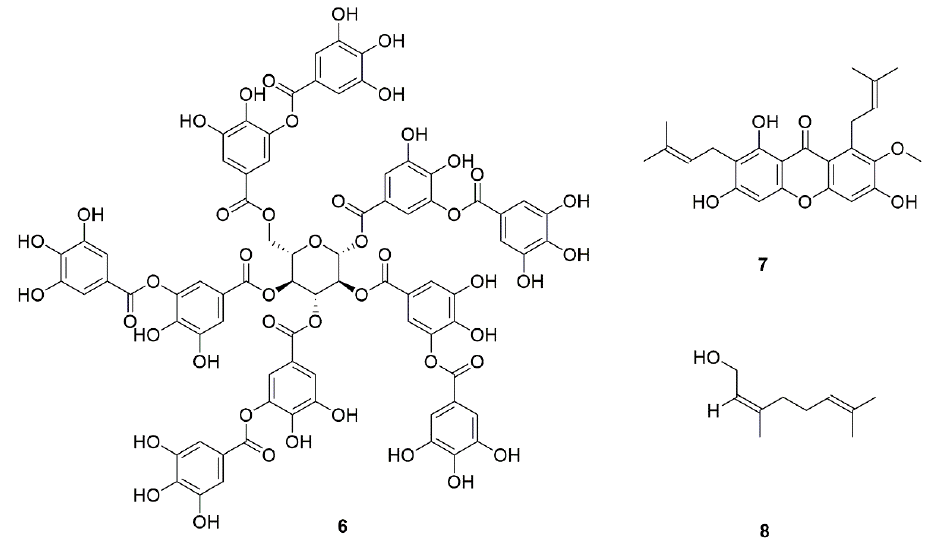
Figure 4. Chemical structures of natural compounds targeting